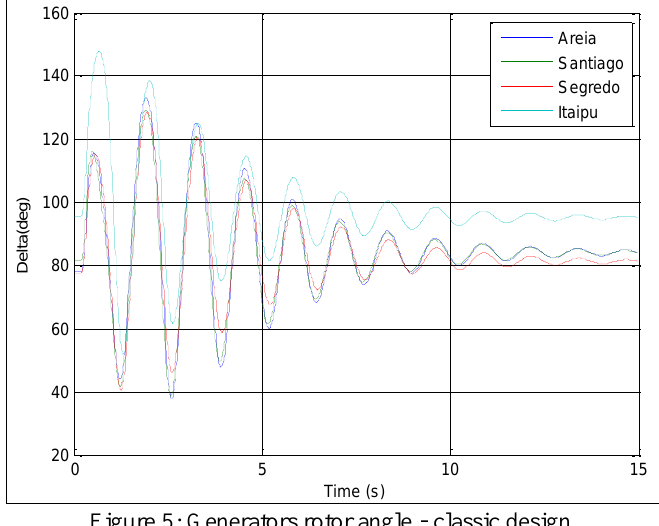
Figure 5: Generators rotor angle - classic design.